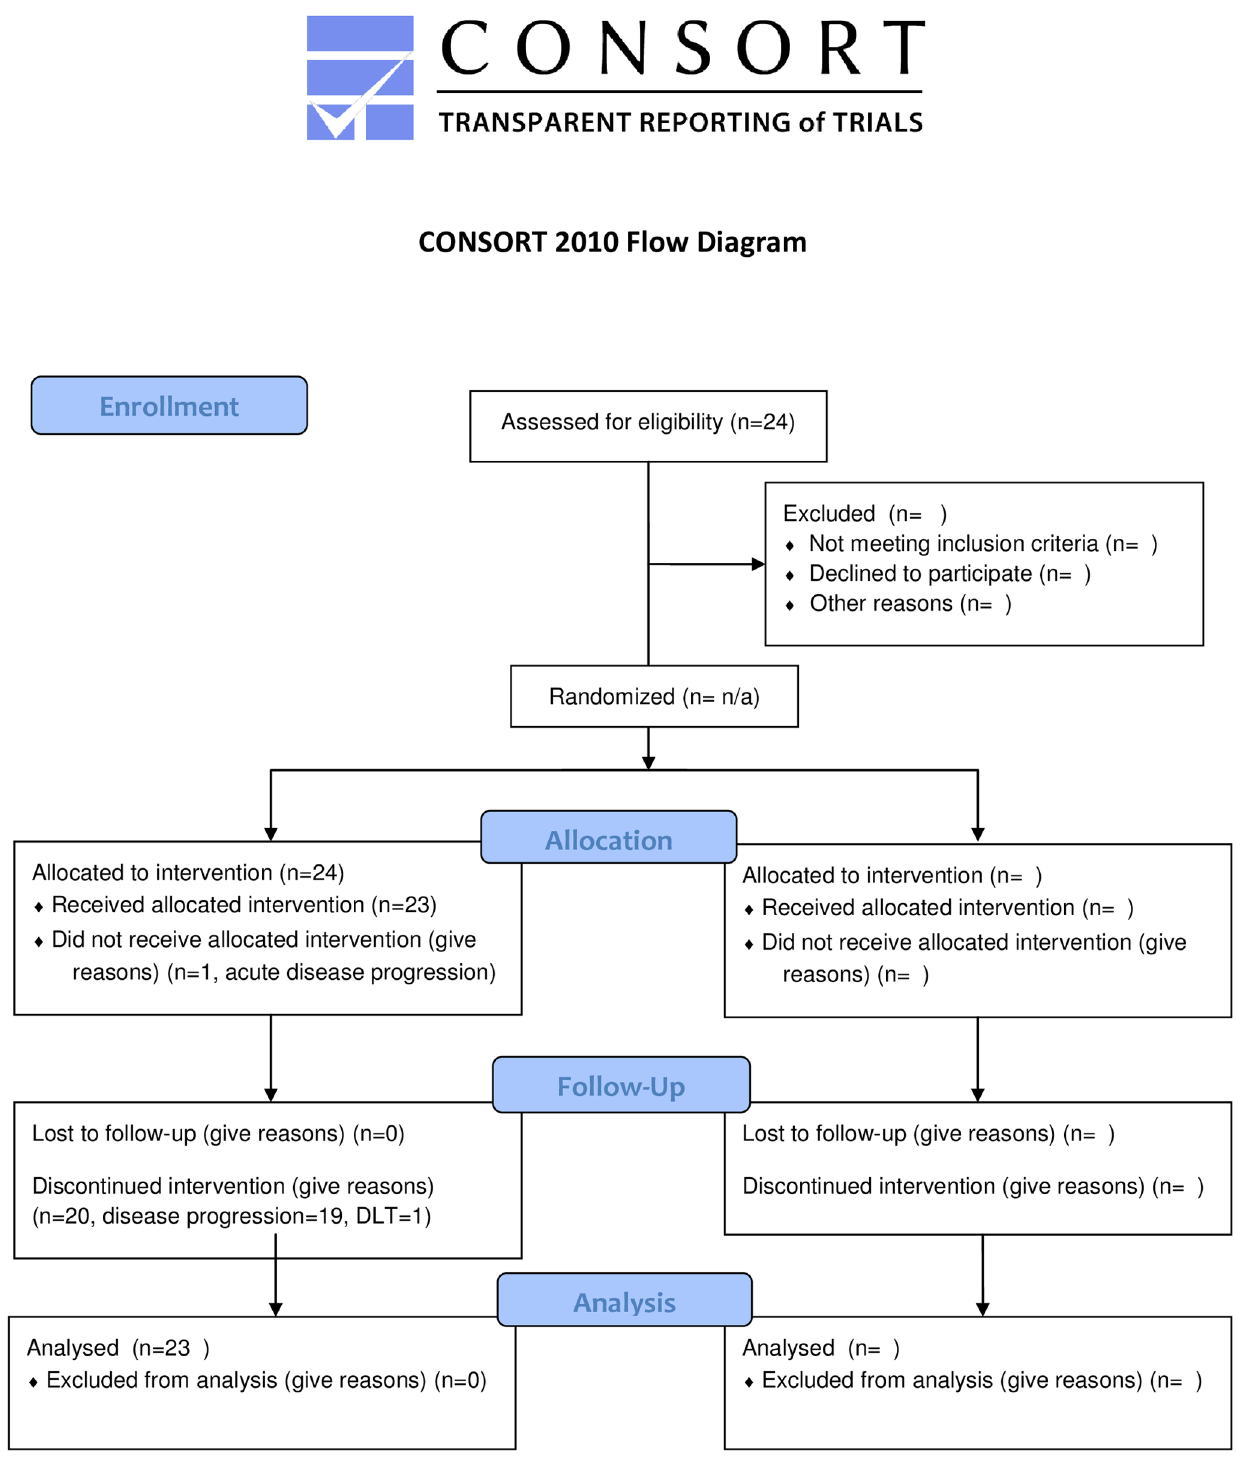
Fig 1. Diagram of study